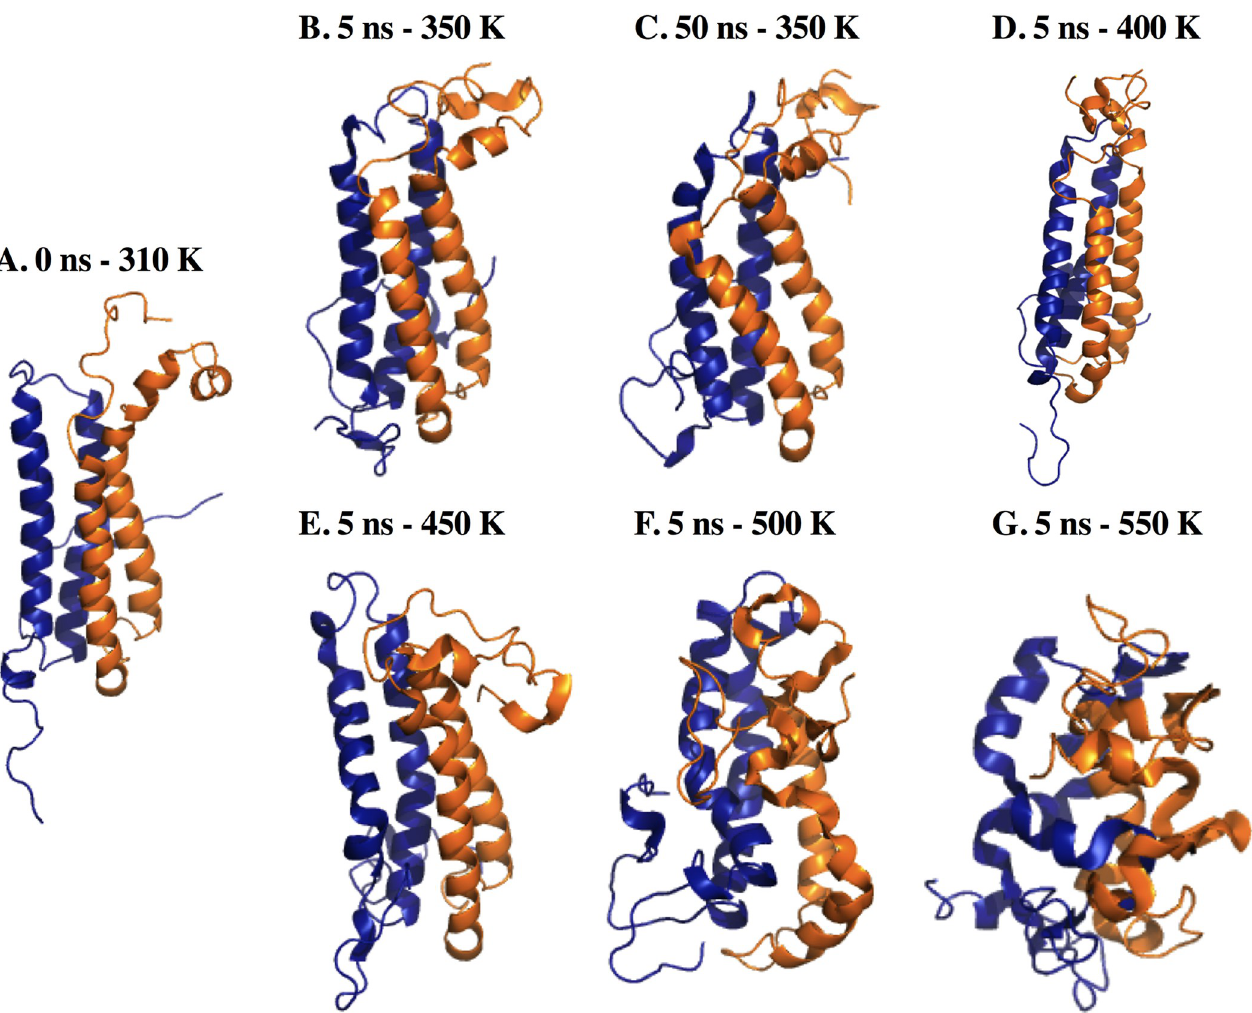
Fig 5. Average structures from EsxG EsxH dimer thermal unfolding simulations. (A). 0 ns of simulation. (B). 5 ns of simulation at 350 K. (C). 50 ns of simulation at 350 K. (D). 5 ns of simulation at 400 K. (E). 5 ns of simulation at 450 K. (F). 5 ns of simulation at 500 K. (G). 5 ns of simulation at 550 K.